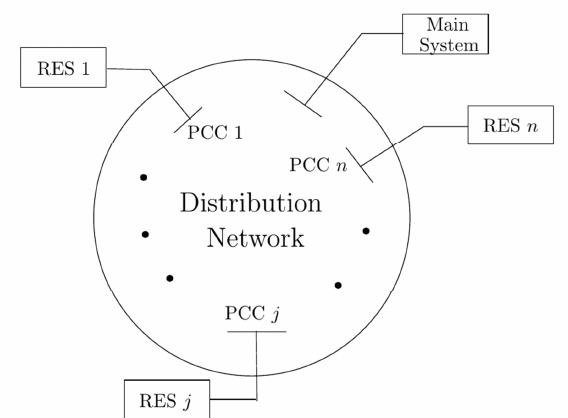
Figure 1. Smart Grid.